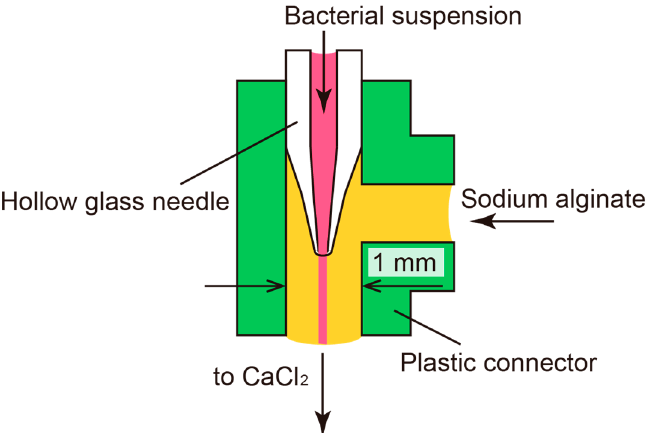
Figure 2. Formation of the microfiber using a co-flowing microfluidic device. The bacterial suspension is introduced from a hollow glass needle with an inner diameter of 100 μ m at the tip. Sodium alginate solution is introduced from the other inlet. The produced coaxial laminar flow is extruded into a calcium chloride solution, which results in the formation of a hollow microfiber made of calcium alginate hydrogel.